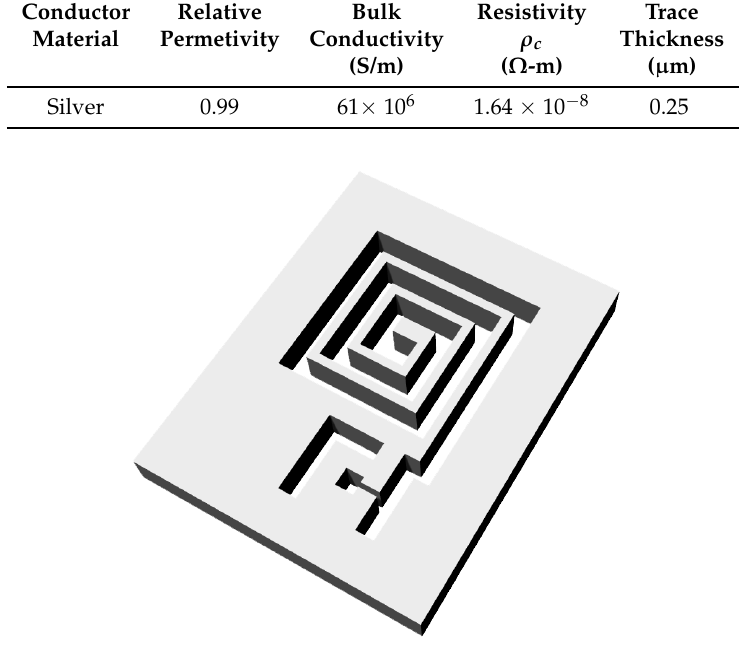
Figure 3. Rendering of the designed 3D-CAD stencil